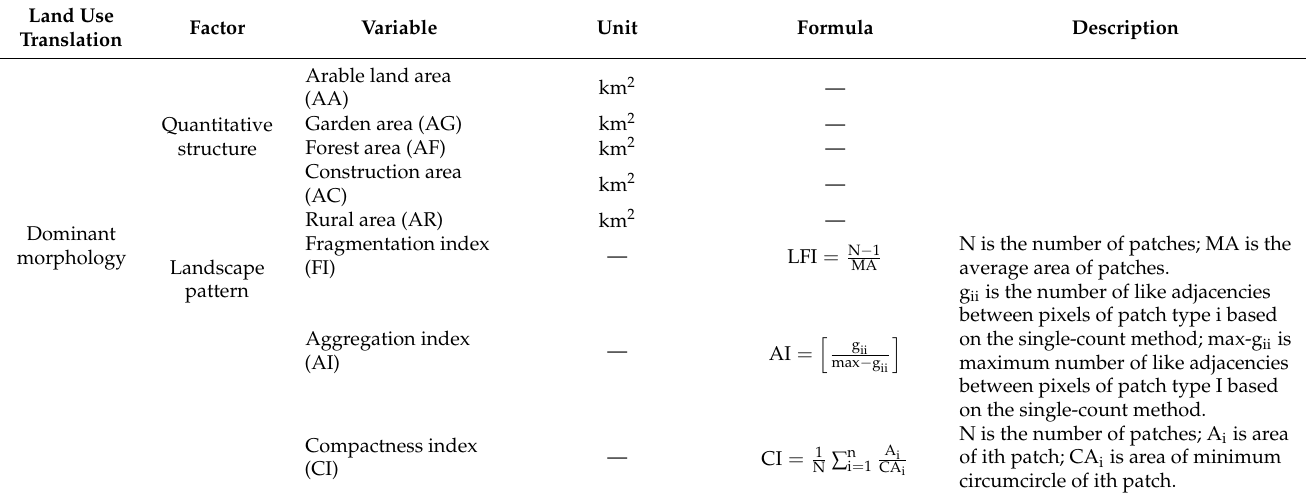
Table 2. Land use translation factors and explanatory